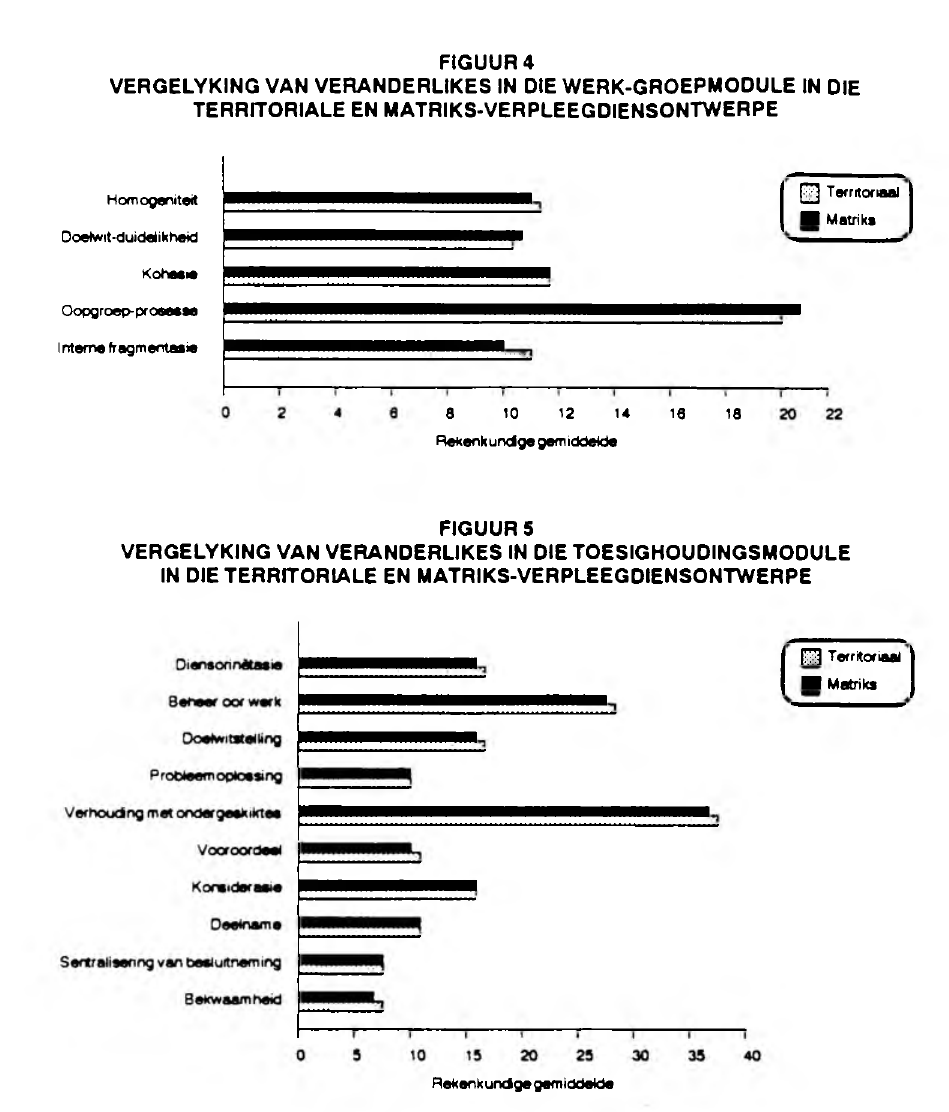
FIGUUR4 VERGELYKING VAN VERANDERLIKES IN DIE WERK-GROEPMODULE IN DIE